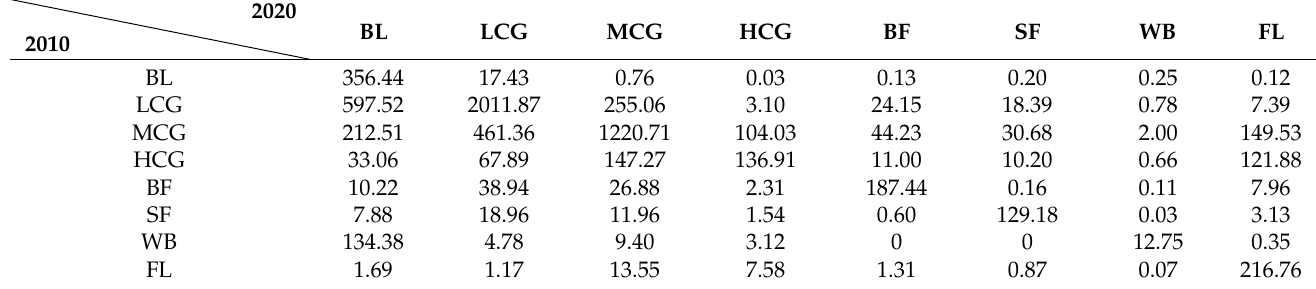
Table A7. Ecosystem service value changes from 2010 to 2020 (106